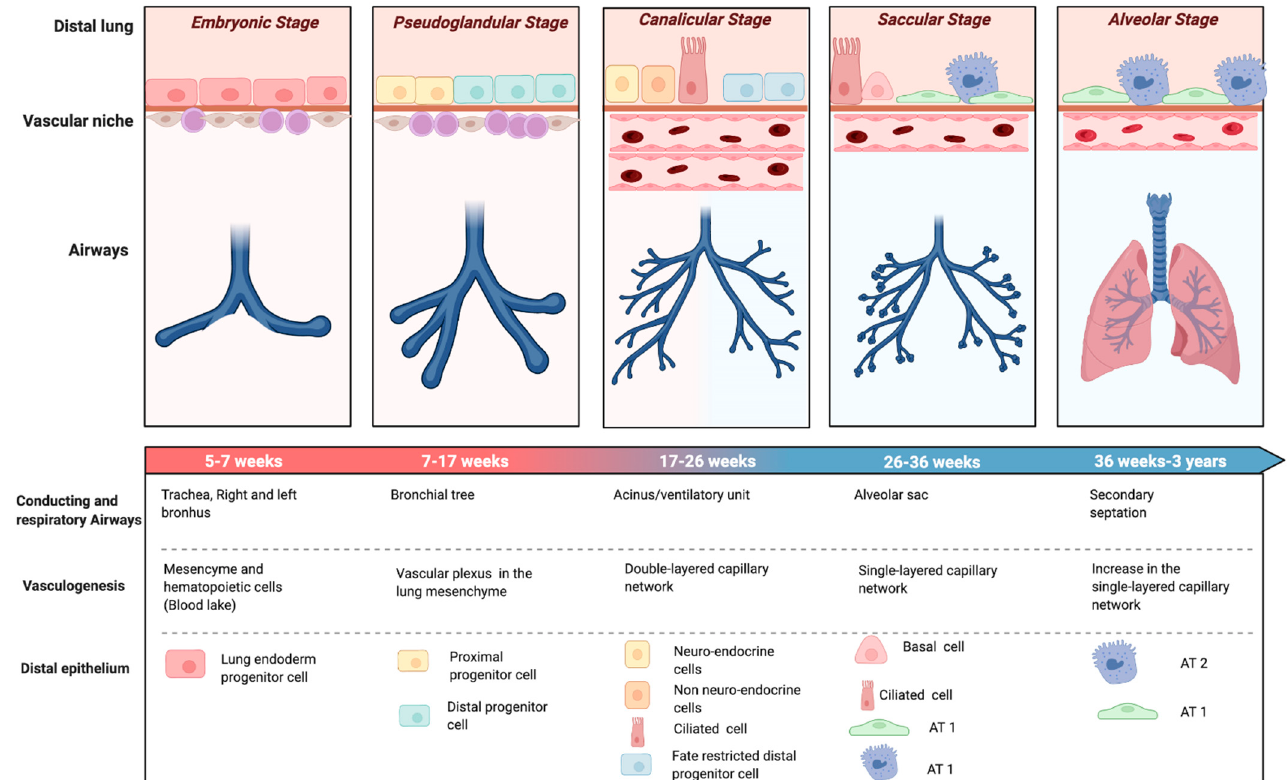
Figure 1. Stages of lung development. Evolution of the airways, epithelial and vascular components of the distal lung through pulmonary development. Abbreviations: Alveolar type 1 cells (AT1), Alveolar type 2 cells (AT2). Created with BioRender.com.